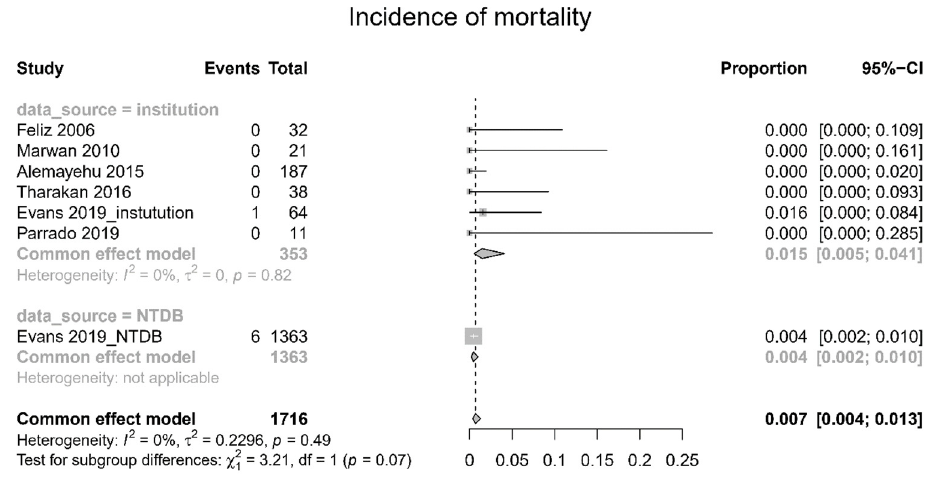
Figure 4. Pooled incidence of morbidity and mortality. ( a ) Complications; ( b ) mortality.